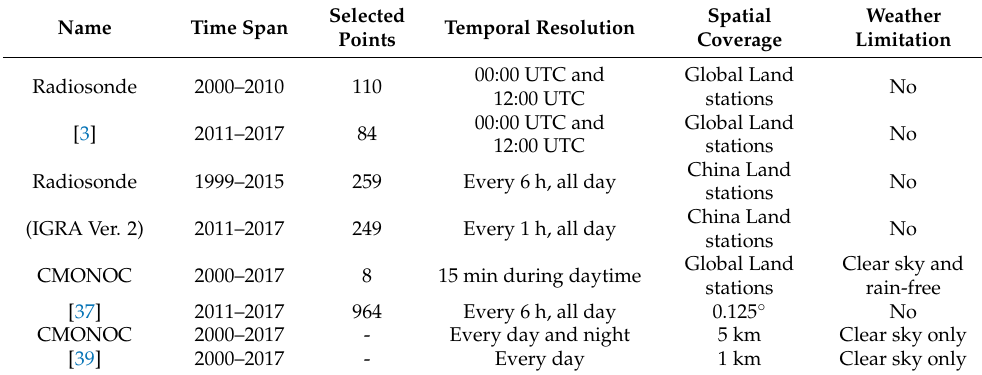
Table 1. Characteristics of datasets used in this